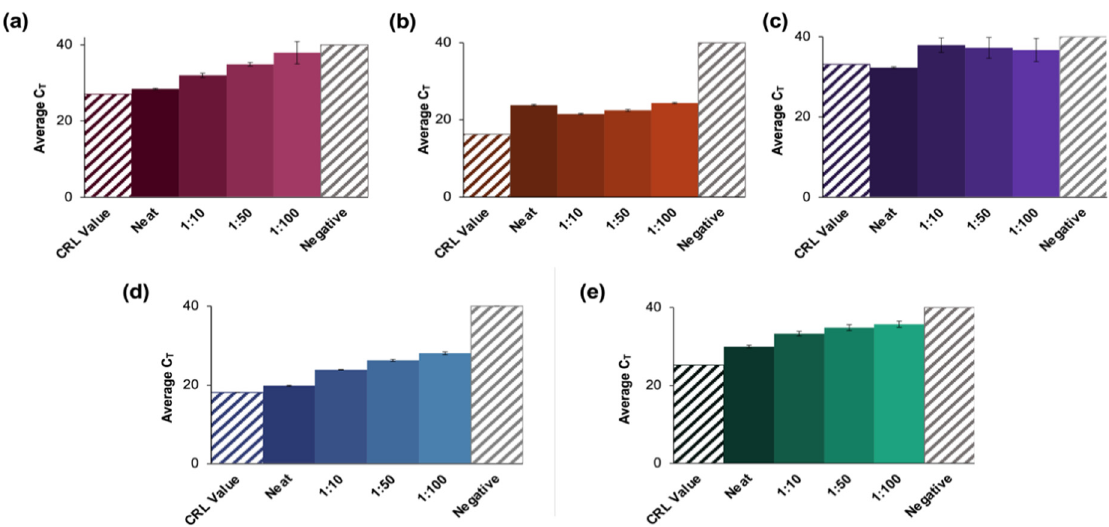
Figure 5. Results of a blind study conducted using CRL clinical saliva samples. ( a – e ) summarize the data obtained from evaluations of blinded CRL samples. Pools for each of 10 blinded samples were created and tested according to the developed protocol and were found to be in 100% agreement with the reported qualitative results (five positive and five negative samples). The significant increase in CT value obtained for ( b , e ) could be attributed to collection at an earlier date than other positive samples. These may thus have had a lower viral load when analyzed than at initial CRL testing. A negative clinical saliva sample was extracted according to the protocol described for pos- itive clinical samples. ( a – e ) represent X2, X5, X7, X8, and X9, respectively, and n = 3 in each case. For